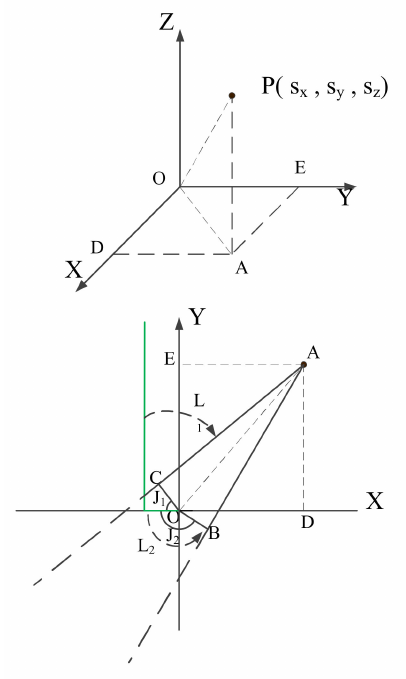
Figure 6. Schematic diagram of the third degree of freedom calculation